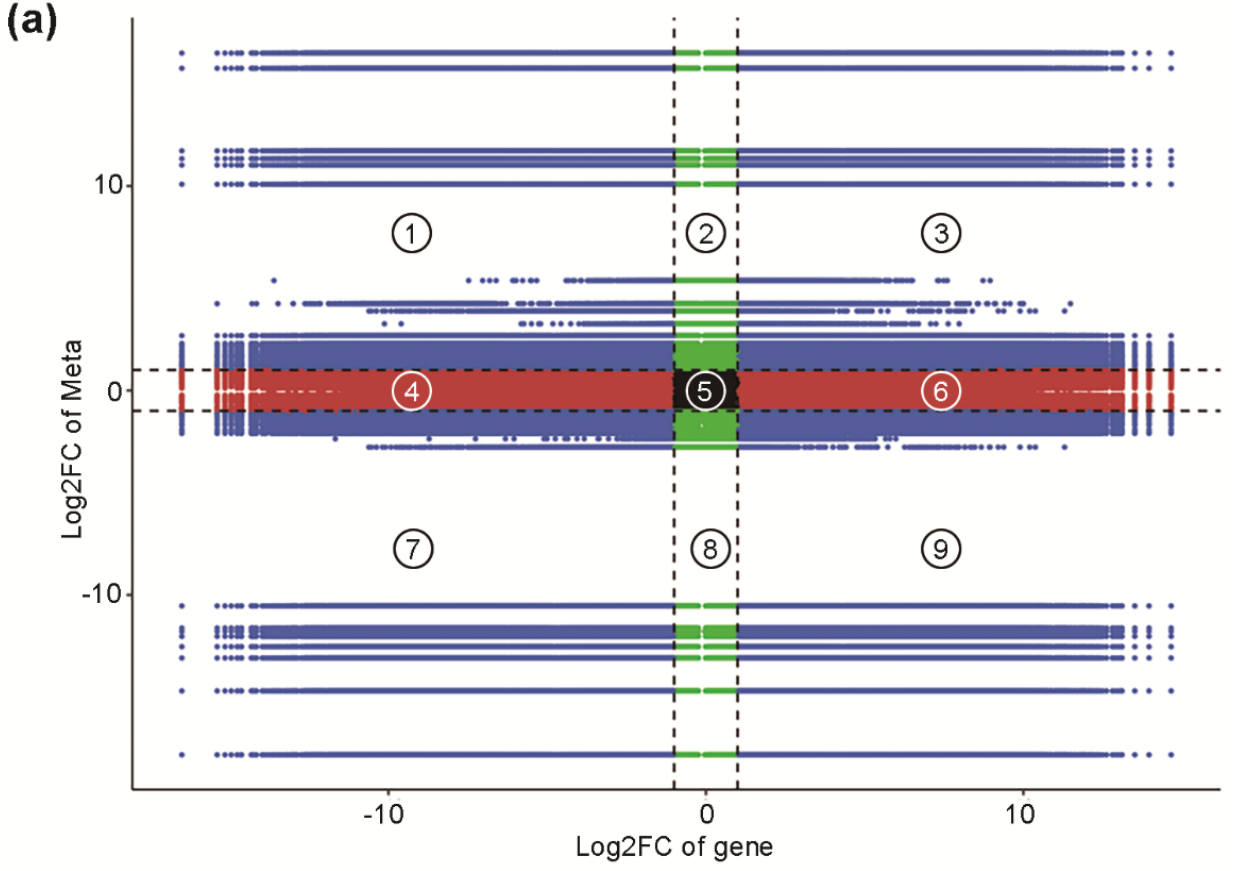
Figure 5. Combined analyses of anthocyanin-related genes and metabolites. ( a ) Nine-quadrant flat. The x-axis represents the log2 ratio of genes. The y-axis represents the log2 ratio of metabolites. Black dotted lines represent different threshold and divide the flat into ① – ⑨ quadrants from left to right and from top to bottom. ( b ) Diagram of genes involved in regulating anthocyanins. The red enzymes represent upregulated genes. PAL: phenylalanine ammonia lyase; 4CL: 4-coumarate CoA ligase; C4H: trans-cinnamate 4-monooxygenase; HCT: shikimate O-hydroxycinnamoyltransferase; CHS: chalcone synthase; CHI: chalcone isomerase; F3H: flavanone 3- hydroxylase; F3′H: flavonoid 3′ -hydroxylase; DFR: dihydroflavonol 4-reductase; ANS: anthocyanidin synthase; UFGT: anthocy- anidin 3-Oglucosyltransferase.